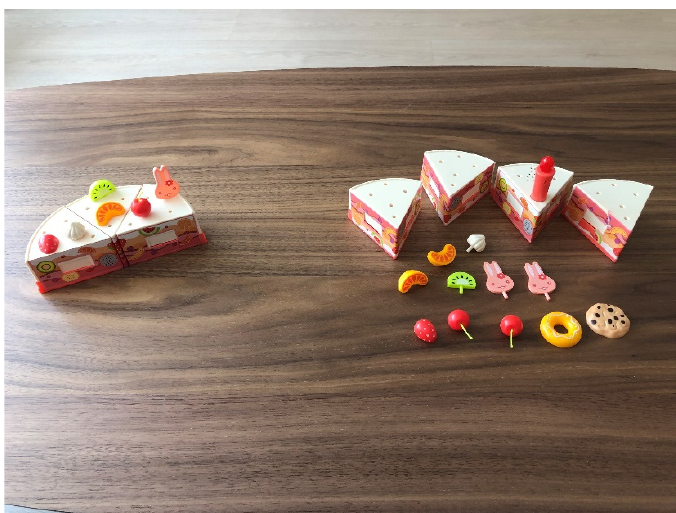
Figure 2. On the left, a sample pie as shown to the participants by the researcher. On the right, the parts that the participant received to match the sample pie.